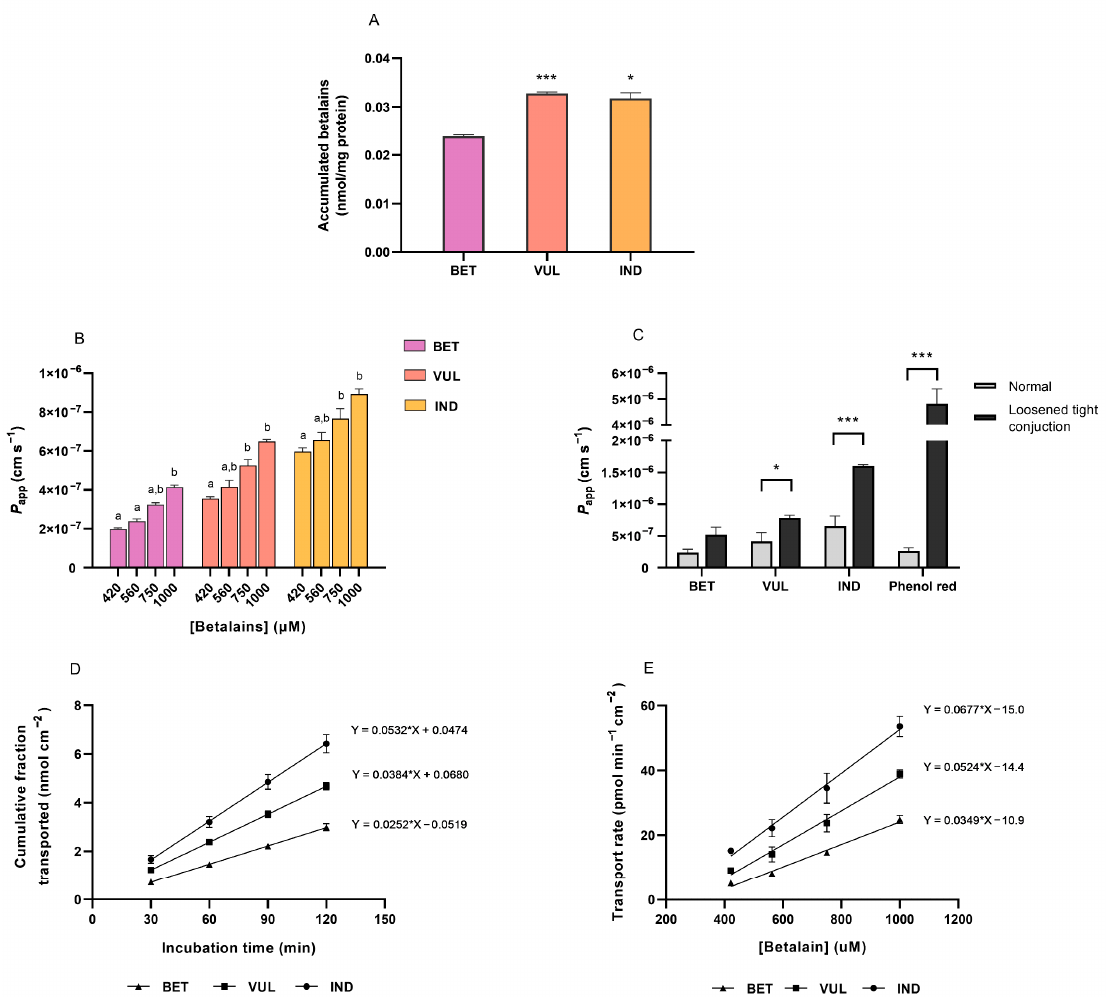
Figure 5. Uptake and trans-epithelial transport of purified BET, VUL and IND across Caco-2 intestinal membrane over 2 h incubation period, illustrated by ( A ) intracellular concentration, ( B ) apparent permeability coefficient ( P app ) at normal condition, ( C ) P app across the membrane with normal vs. loosened tight junction, ( D ) transport kinetics at apical betalain concentration of 1 mM, and ( E ) dose-dependent transport rate of three betalains. Values are mean with SEM of 3–4 independent experiments. Significant differences are shown in ( A , C ) as * p < 0.05 and *** p < 0.001 comparing betalains to BET ( A ) and against controls ( C ). Different letters in ( B ) indicate significant differences between concentrations within one betalain ( p < 0.05).